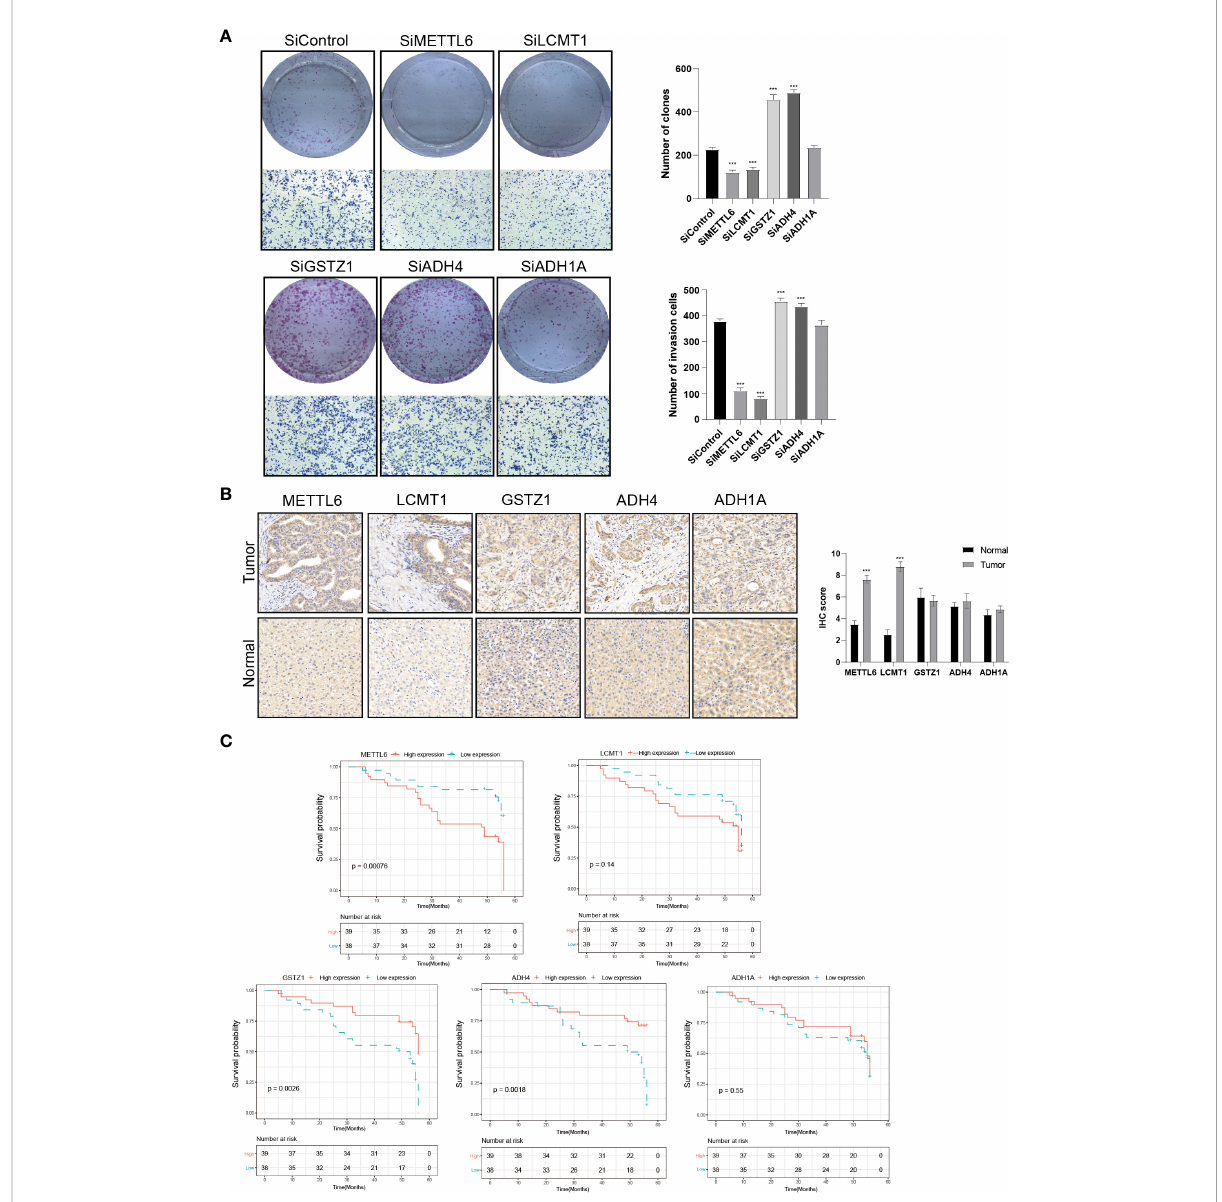
FIGURE 10 Validation of the Five prognostic TRGs by functional analysis. (A) Clone formation and invasion analysis of Hep3B cells depleted with the fi ve TRGs. (B) IHC analysis of the fi ve TRGs in the Xiangya HCC cohort (n = 97), including normal liver tissue (n = 20) and HCC tumor tissues (n = 77). (C) Kaplan-Meier curve analysis of the fi ve TRGs in HCC patients. Patients were divided into high- and low-expression groups based on the median expression of each gene. TRGs, tyrosine metabolism-related genes; HCC, hepatocellular carcinoma; IHC, immunohistochemistry. ***p <